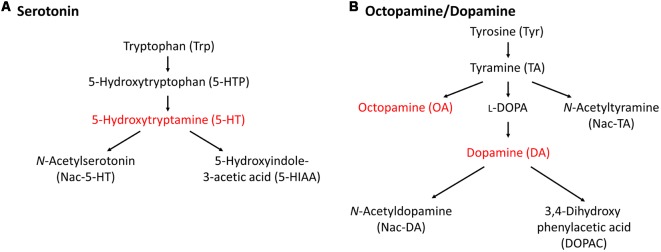
Metabolic pathways of monoamines. (A) 5-HT metabolic pathway. (B) Octopamine/dopamine metabolic pathway. Only the monoamines that we could measure in the high-performance liquid chromatography (HPLC) assay for the Lymnaea central nervous system (CNS) are indicated. This figure was modified from Aonuma et al. (2018b). This article was published in Biophys. Physicobiol., and thus the reuse of contents is permitted by the CC BY 4.0 license.